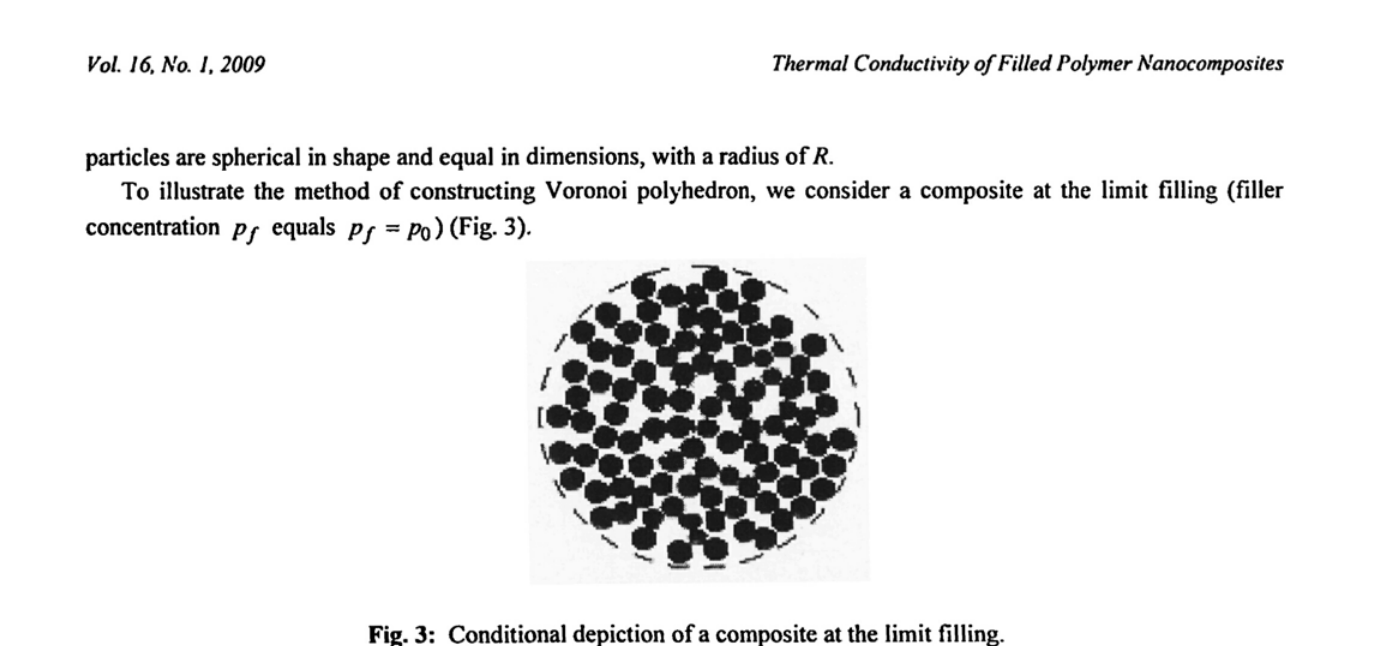
Fig. 3: Conditional depiction of a composite at the limit filling.